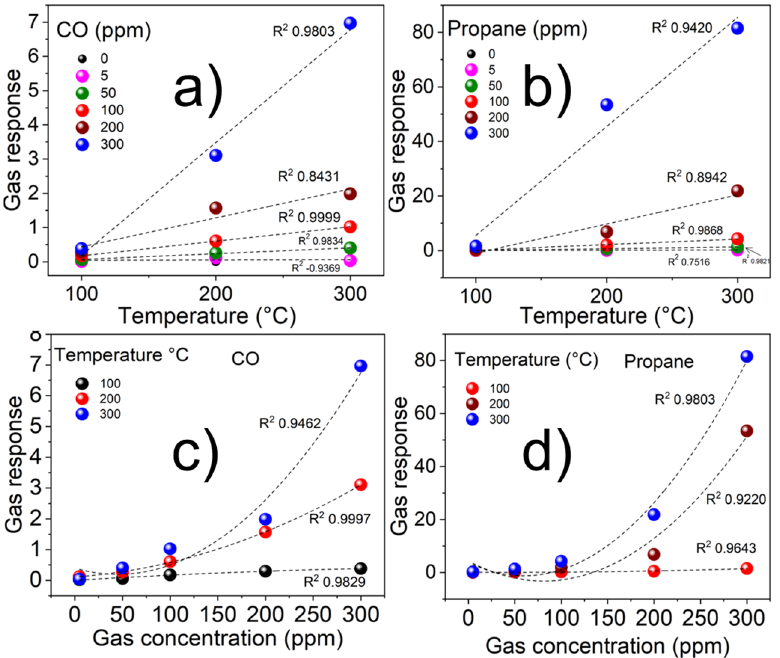
Figure 12. Curve fitting using linear and nonlinear regression of ZnAl 2 O 4 ’s response in propane and CO as a function of: ( a , b ) temperature, ( c , d ) gas concentration.